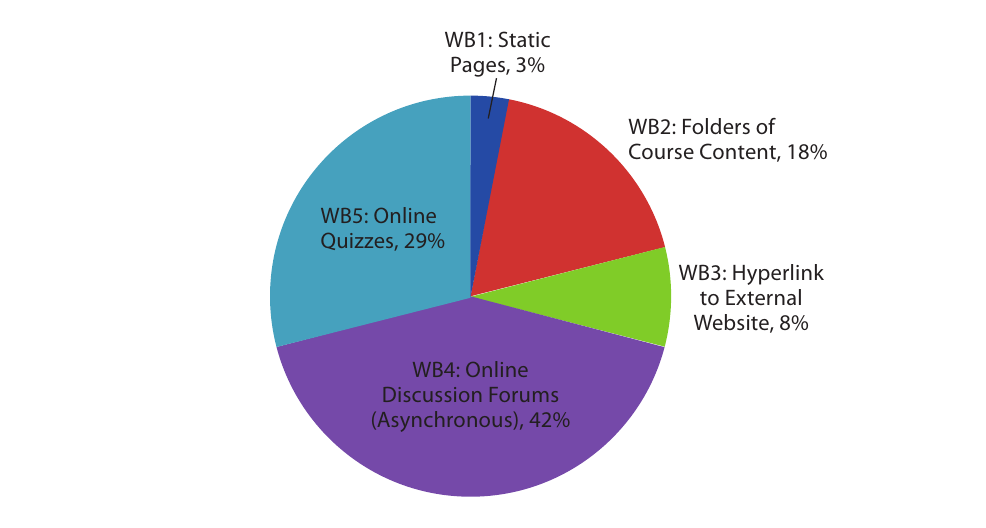
Figure 4 Distribution of learners’ access to online resources